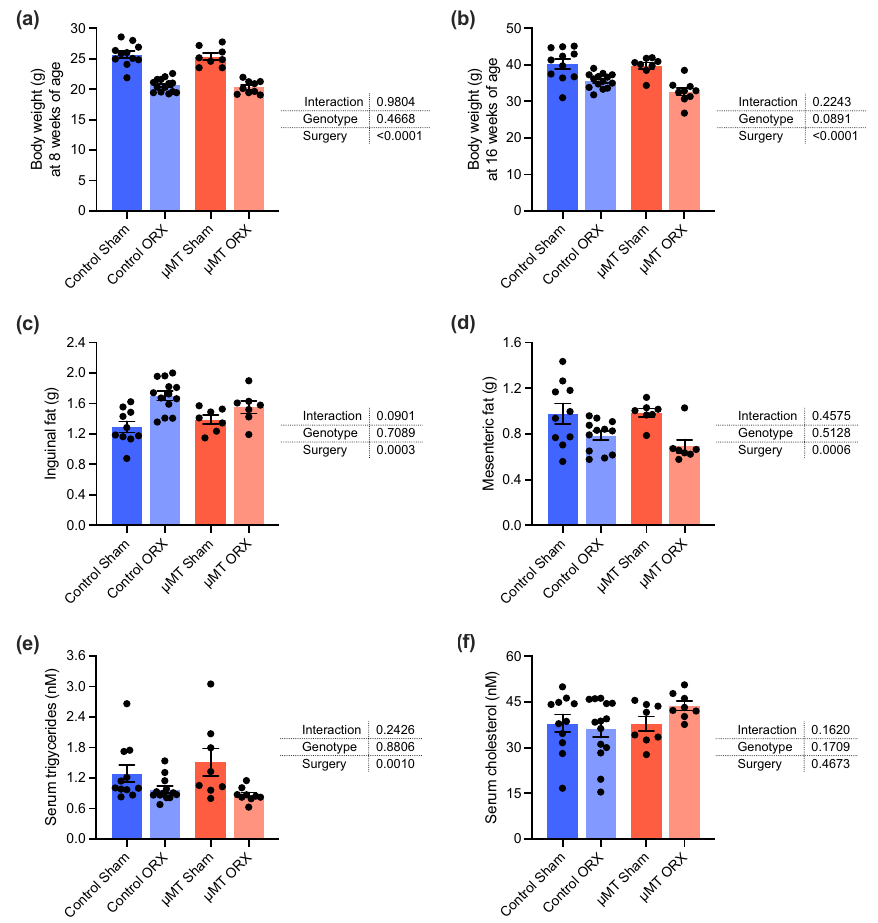
Figure 2. Body weights, weights of fat depots and serum lipids in the µMT/castration model. µMT and control Apoe -/- mice were castrated (orchiectomized, ORX) or sham-operated (Sham) at 3 weeks of age and fed a high- fat diet between 8 and 16 weeks of age. Body weights were recorded at 8 (a) and 16 weeks (b) of age (n = 8–14/ group). Inguinal (c) and mesenteric fat (d) depot weights were recorded and serum for triglyceride (e) and cholesterol (f) measurement were collected at 16 weeks of age (n = 7–14/group). Data were analyzed by 2-way ANOVA. Bars indicate means, error bars indicate SEM, and circles represent individual